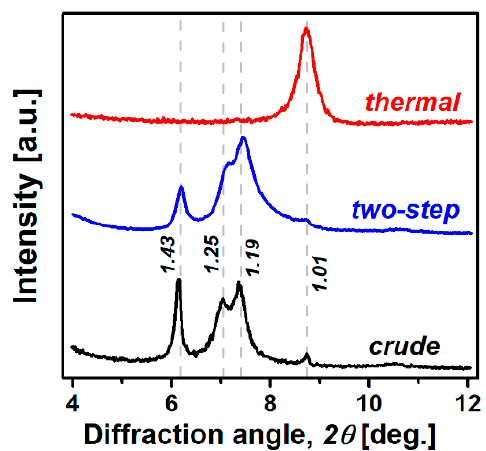
Figure 6. PXRD patterns of crude vermiculite and its two expanded forms prepared by H 2 O 2 treatment coupled with microwave drying and prompt heating. The designated values correspond to d -spacings at the nanometer scale.